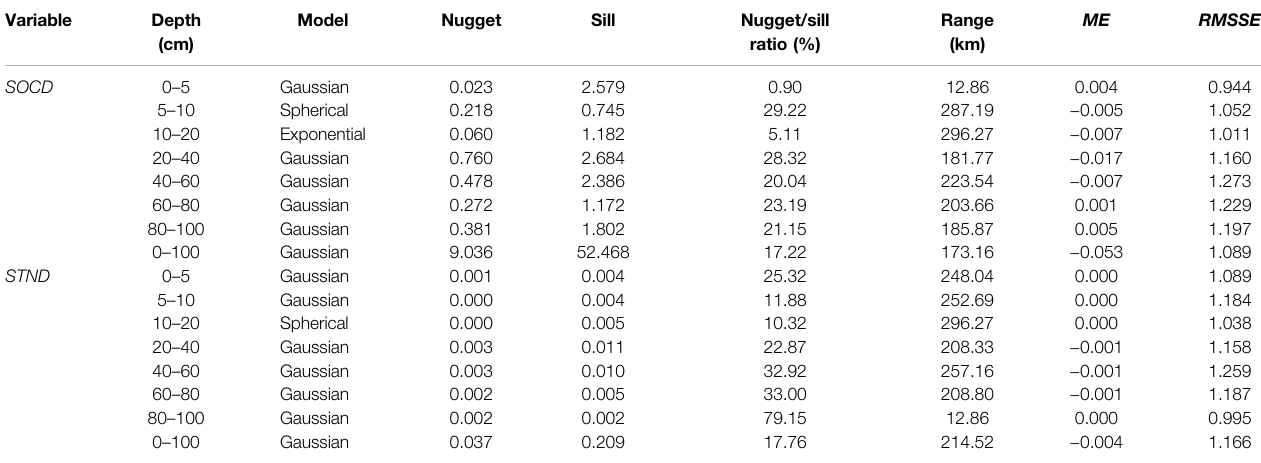
a ME and RMSSE represent the mean error and the root-mean-square standardized error, respectively.